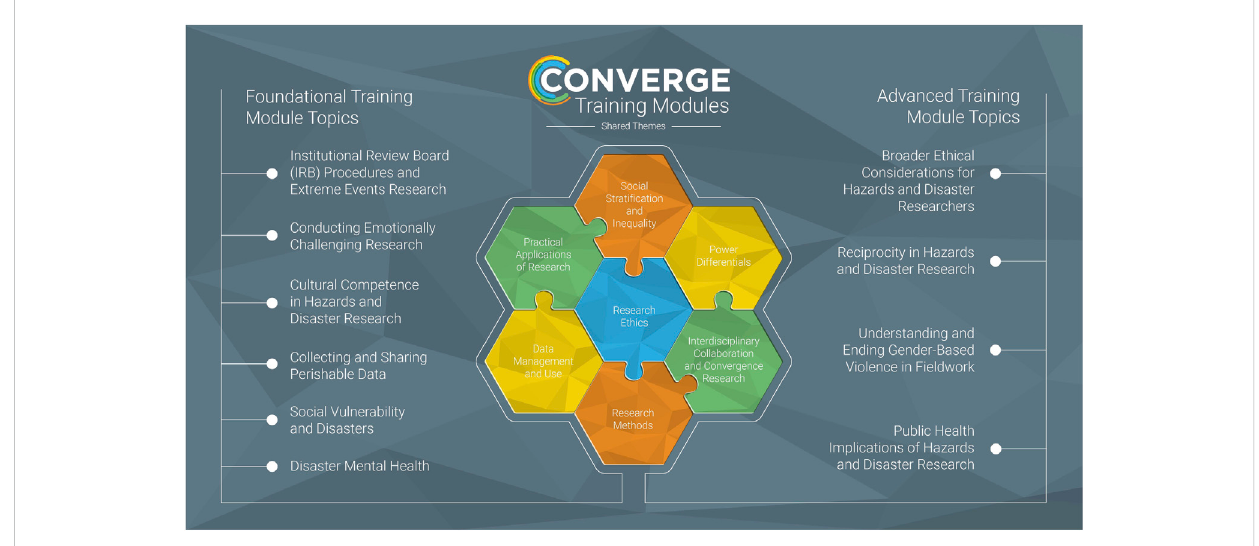
FIGURE 1 CONVERGE Training Module series cross-cutting